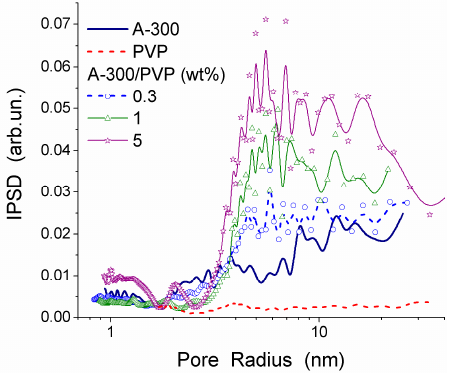
Figure 19. PSD ( k GT = 70 K nm) for A-300/PVP systems (adapted from [13]).